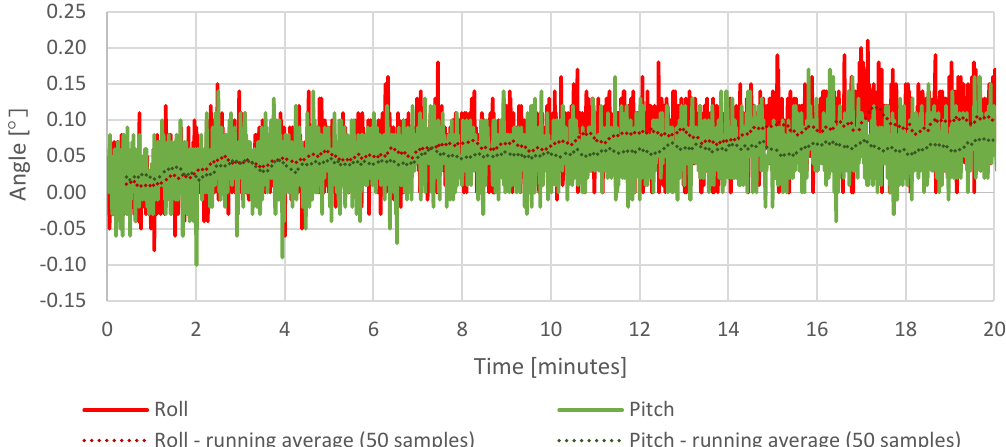
Sensors 2019 , 19 , x FOR PEER REVIEW Figure 19. Stationary measurements of estimated roll and pitch angles. Figure 19. Stationary measurements of estimated roll and pitch angles.